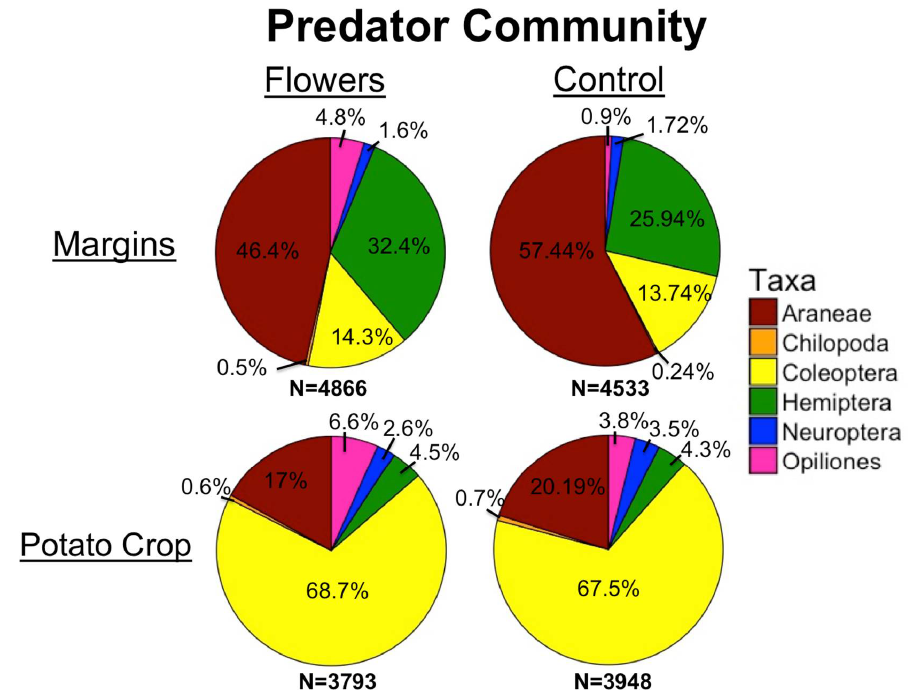
Figure 7. Predator community in margins and potato crops, with and without floral plantings. Based on our results, growers and conservationists should evaluate how best to utilize floral plantings to achieve their desired outcomes. From a conservation standpoint, commercially available seed mixtures such as the one used in our study may act to increase both pollinator and predator abundance when established on a large scale in conventionally managed agroecosystems. Additionally, greater floral cover provided by floral plantings will likely result in greater pollinator abundance, and should be encouraged if the goal is related to pollinator conservation. However, if the intention is to promote predators, the presence of plantings appears to be more impactful than increased floral cover, and the necessity of flower-dense plantings is more questionable. Finally, while such floral plantings increase beneficial inset abundance within margins, there were limited effects in nearby potato crops, and the number of bees in the crop actually decreased. Growers seeking to increase pollination or biological control services may need to consider how best to encourage beneficial insects to spill over into adjacent crops instead of simply creating floral plantings. 5. Conclusions Floral plantings can promote pollinators and predators within commercial agroecosystems, while limiting disruption to growers. Our results show that when floral plantings are established on a large scale on commercial farms, they increase the overall abundance of both pollinators and predators. In particular, pollinators respond positively to increased floral cover, whereas predators appear to benefit from other factors associated with floral plantings. The numbers of beneficial insects did not increase in nearby potato fields however, indicating that floral plantings may act to concentrate pollinators and predators rather than export them to surrounding areas. These results can help policy makers and growers determine how best to manage land in order to provide